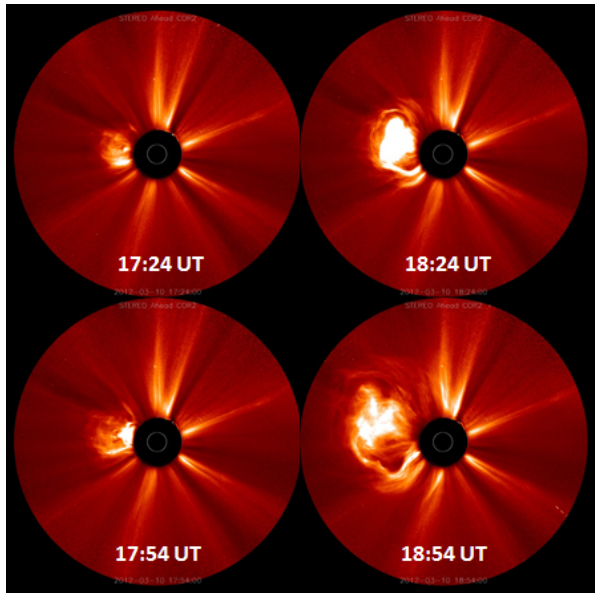
Figure 1. Solar images obtained from the STEREO Ahead COR2 observations at 17:24, 17:54, 18:24, and 18:54UT on 10 March